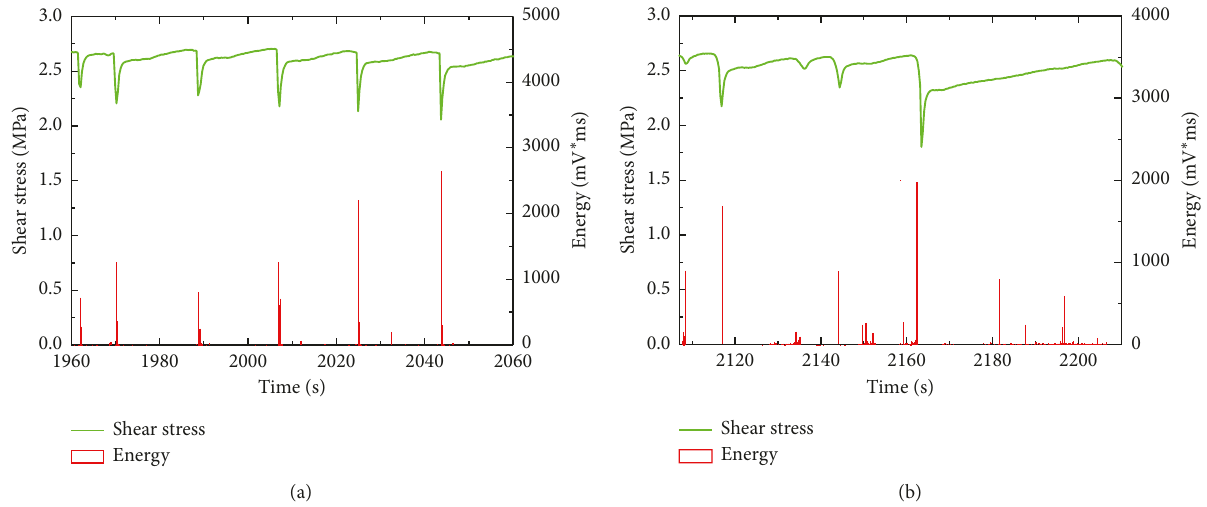
Figure 5: Relationship between shear stress and AE energy of (a) Sample 1 and (b) Sample 4.